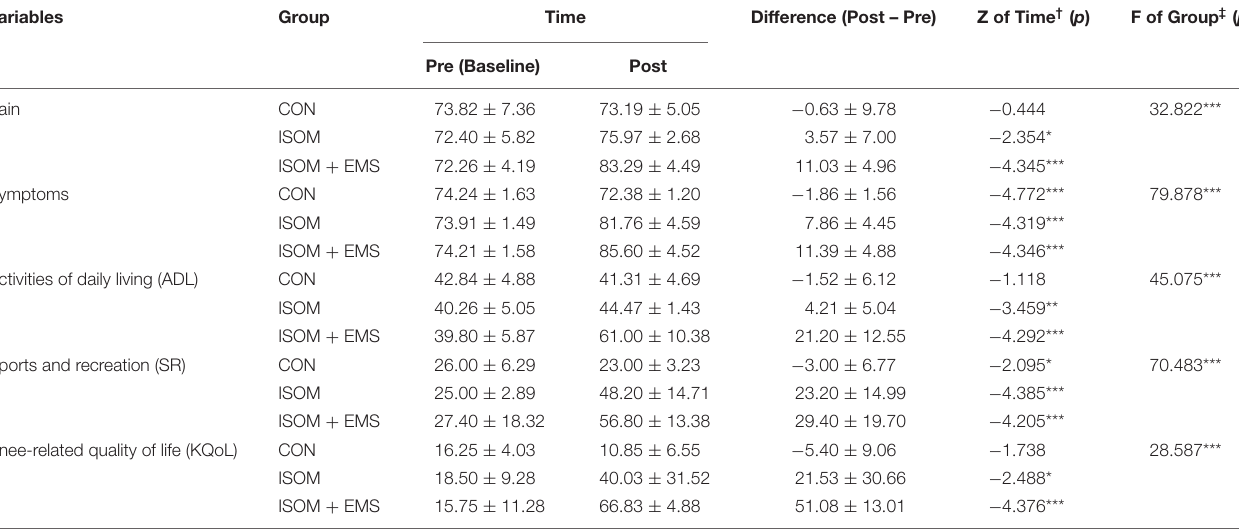
TABLE 8 | Differences and Changes in KOOS scores.